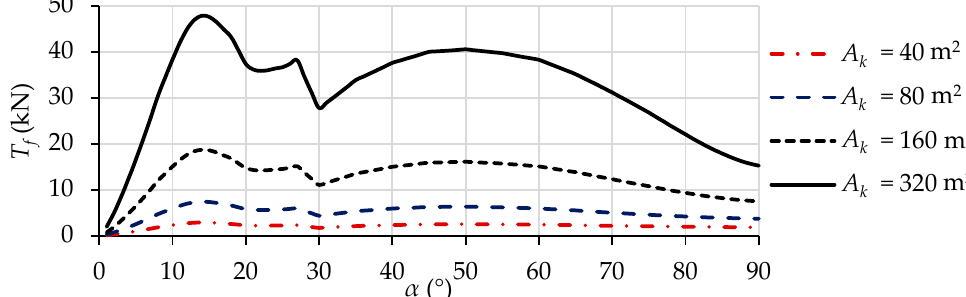
Figure 12. The front bridle line tensions for each kite area and angle of attack at a ship speed of 7.27 m/s and a reference wind speed of 20 m/s.